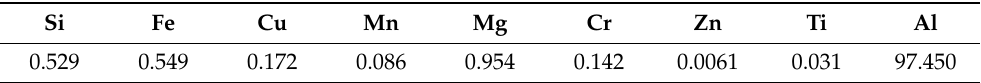
Table 1. Chemical composition of Al6061 alloy